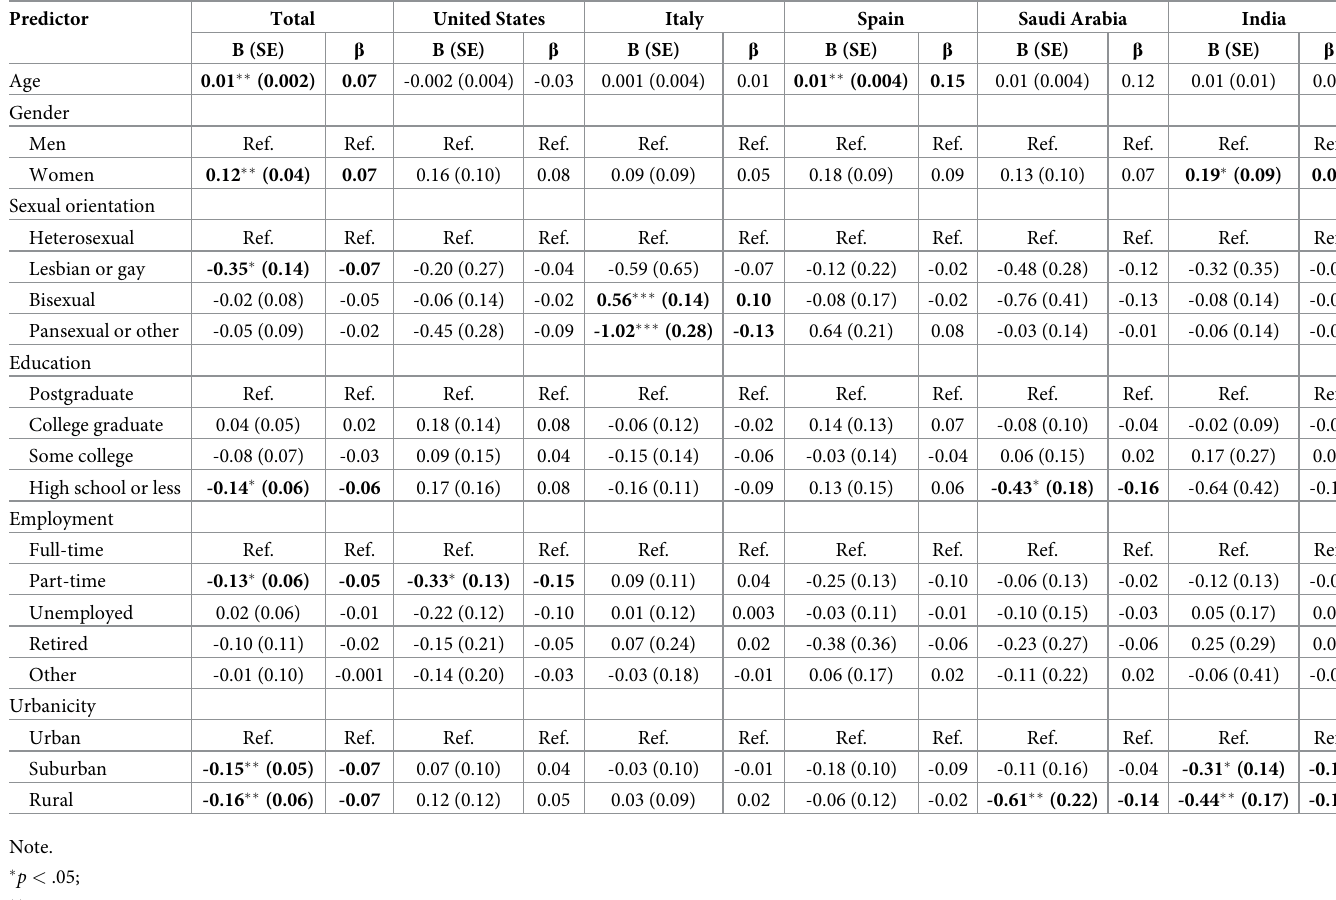
Table 4. Unstandardized and standardized multivariable linear regression weights for hand washing behavior, stratified by country.